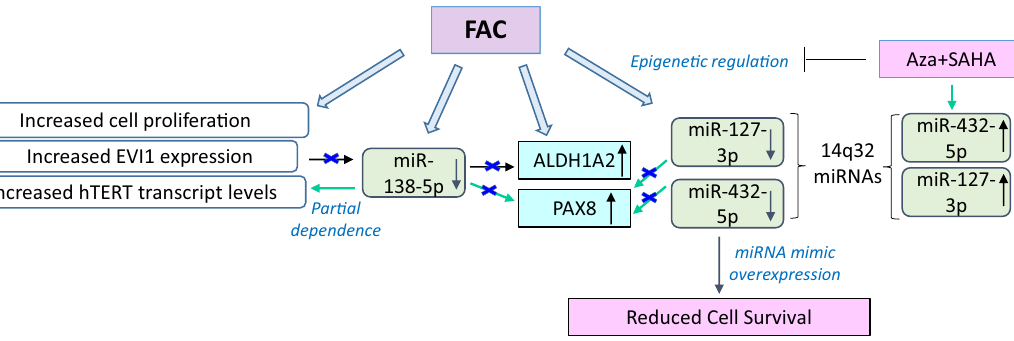
Figure 10. Proposed model for 14q32 miRNA regulation with combination of DNMT inhibition and HDAC inhibition. We previously reported that chronic iron overload contributes towards oncogenic transformative events, which potentially recapitulate early events in HGSOC transformation. Microarray analyses identified markedly reduced levels of miR-432 and miR-127 (located at 14q32) in FAC-treated FT194 cells. We propose that the FAC-induced reduction in the miRNA levels was a result of epigenetic alterations, specifically in their methylation and acetylation status. Inhibition of DNA methyltransferases (using AZA) and HDACs (using SAHA) led to a reversal of the levels of these specific miRNAs in these chronic iron exposed FTSECs. We previously reported that chronic FAC treatment of FT194 cells notably increased TERT mRNA levels 10 as well as ALDH1A2 protein (from our proteomic analyses, validated via western analysis). We now identified that overexpression of miR-138-5p (located at 3p21) could antagonize the FAC-induced TERT transcript levels; however, miR-138-5p expression did not modulate ALDH1A2 protein. The above described three miRNAs also commonly alter Pax8 protein expression, which may contribute to FAC-induced changes in FT194 cells. Green arrows denote partial